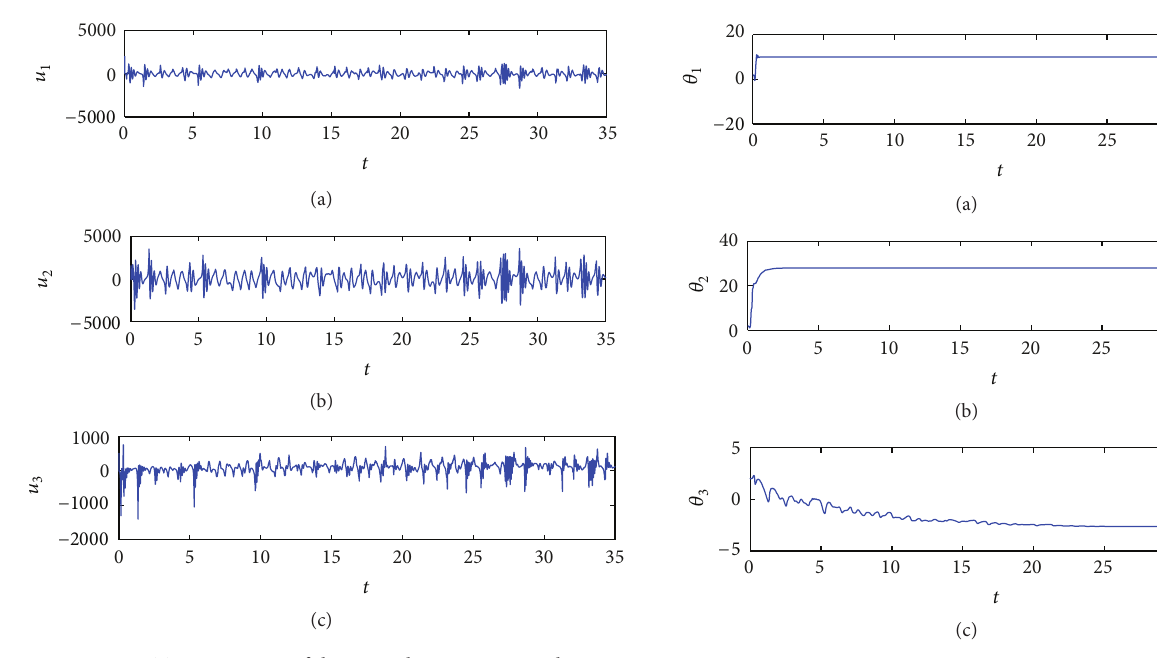
Figure 5: The trajectories of the adaptive laws of the parameter Example